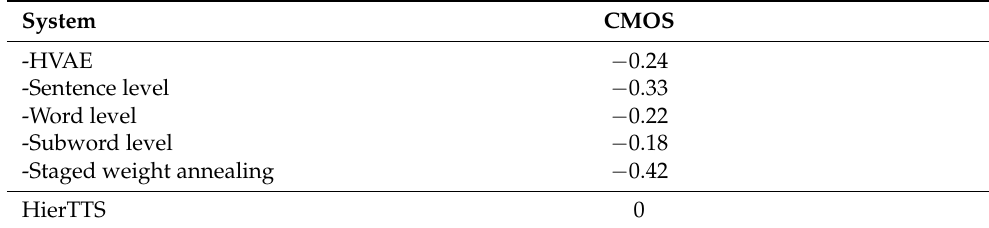
Table 2. CMOS evaluation of ablation